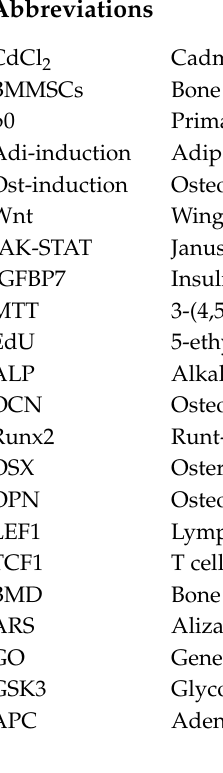
s1, Figure S1: Gene ontology analysis of BMMSCs treated with CdCl 2 ., Table S1: The detailed information of top regulated mRNAs in BMMSCs with CdCl 2 , Table S2: The detailed information of Wnt signaling related mRNAs in BMMSCs with CdCl 2